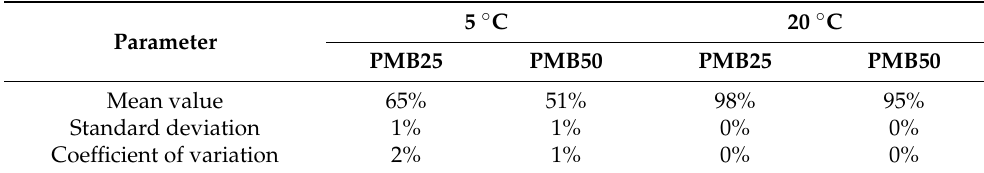
Table 4. Results of elastic recovery, R E (%), of the studied PMBs. 5 ◦ C 20 ◦ C Parameter PMB25 PMB50 PMB25 PMB50 Mean value 65% 51% 98% 95% Standard deviation 1% 1% 0% 0% Coefficient of